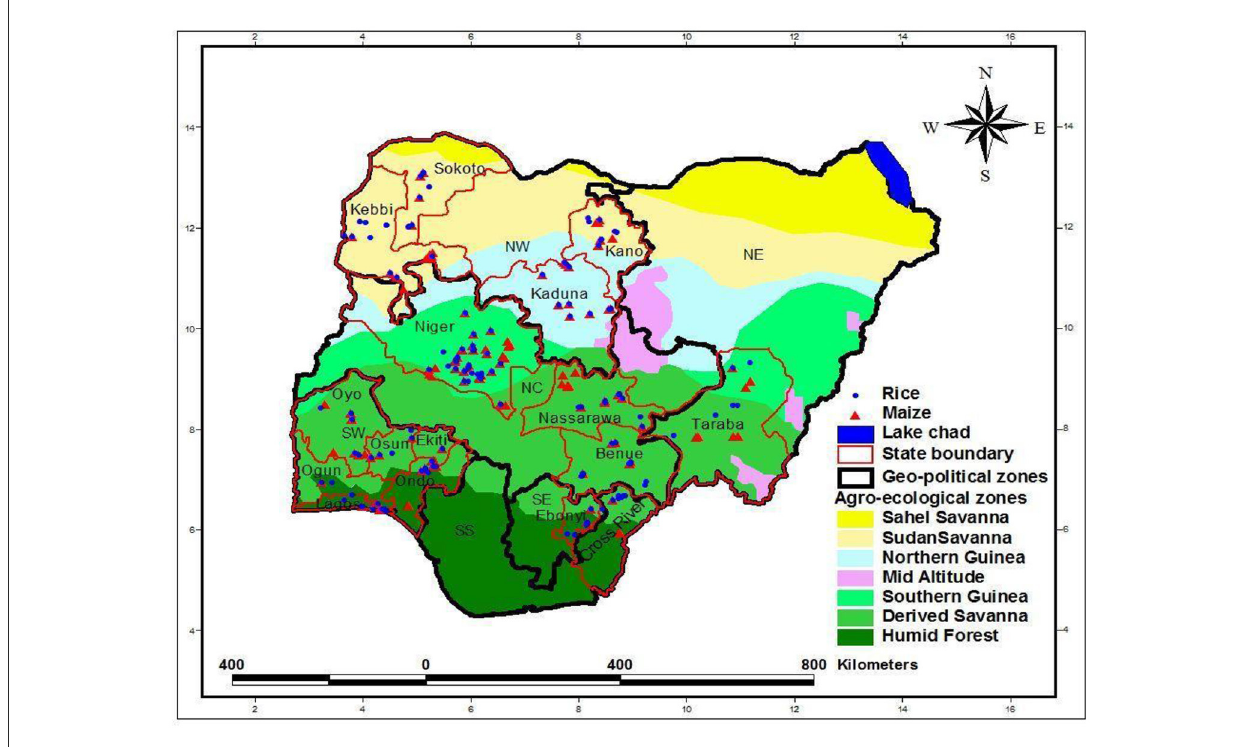
FIGURE1 Map of Nigeria showing the study locations across the agro-ecological and geopolitical zones. Source: Field survey;